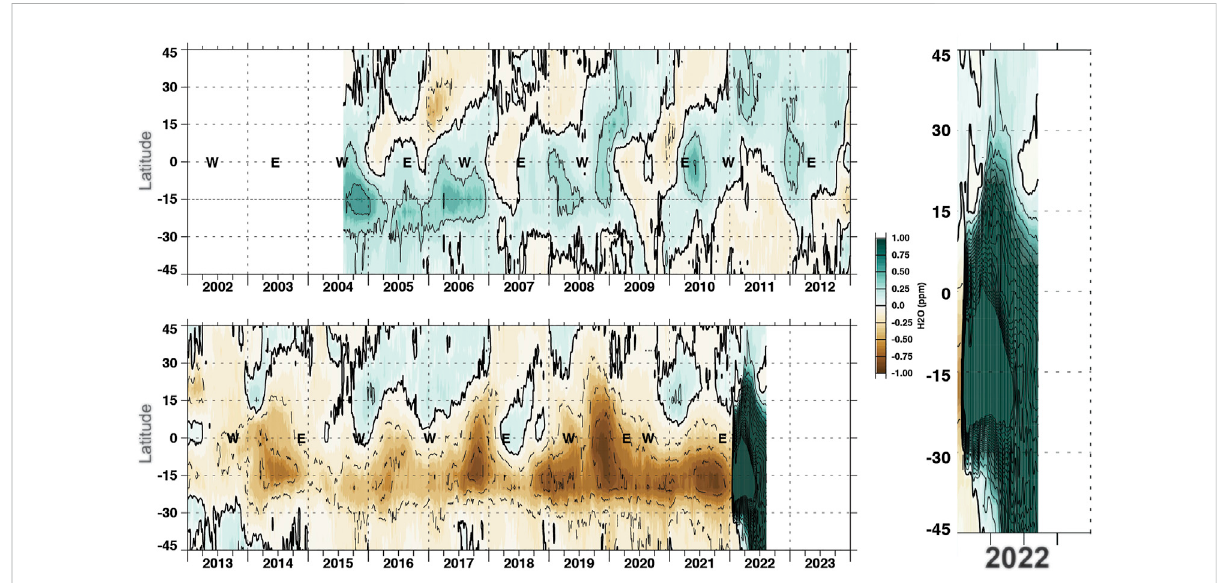
FIGURE 8 Zonal mean stratospheric water vapor at 26.1 hPa (in ppmv) vs. latitude from Aura/MLS (2004-present) showing the unprecedented stratospheric H 2 O anomaly due to the January 2022 HTHH eruption. The left plot shows MLS water vapor gridded into 5 ° latitude bins, with the annual cycle removed, missing data fi lled with linear interpolation, data detrended, and Gaussian smoothing applied (1/2 amplitude = 10 days) to remove higher frequency structure. The easterly (E) and westerly (W) points are as shown in the Singapore zonal winds and indicate the prevailing phase of the Quasi-biennial Oscillation (QBO) of stratospheric winds, which was easterly in January 2022. Zoom-in showing 2022 only is shown on the right . The HTHH water vapor has spread into the northern hemisphere (below ~30 ° N) but most resides in the southern hemisphere. Source: NASA Goddard QBO website (P.A. Newman & N. Kramarova),